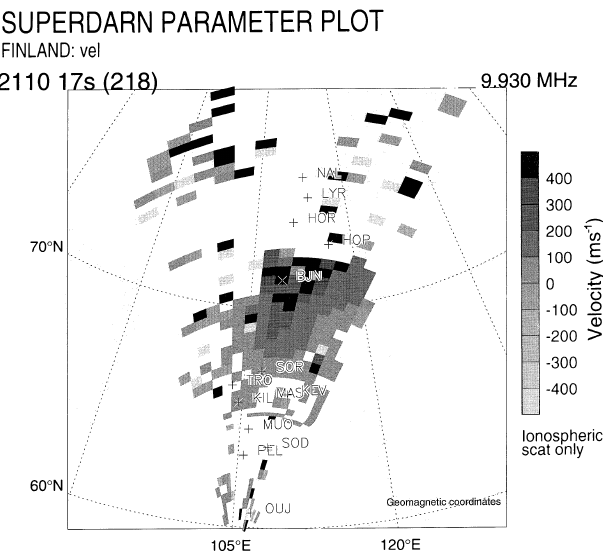
Fig. 5. Line of sight velocity data from a 4 min, 16 beam anticlockwise scan of the CUTLASS Finland radar recorded between 21:10:17–21:14:17 UT, indicating the spatial extent of one of the equatorward velocity pulses shown in Fig. 4. The locations of IMAGE magnetometer stations are